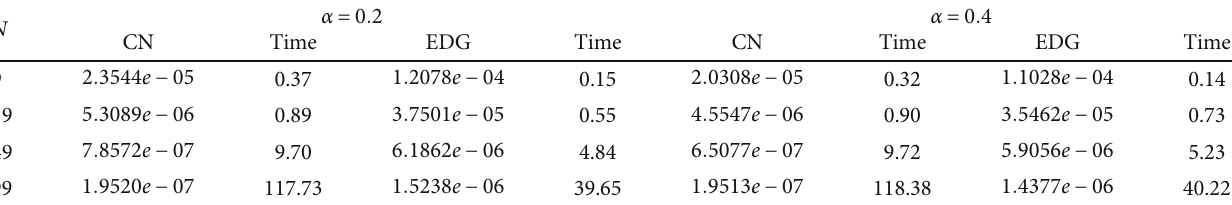
Table 10: Absolute errors of Example 17 at T = 1 for Re = 100 , Δ t = 0 : 01 , α = 0 : 6 , and α = 0 : 8